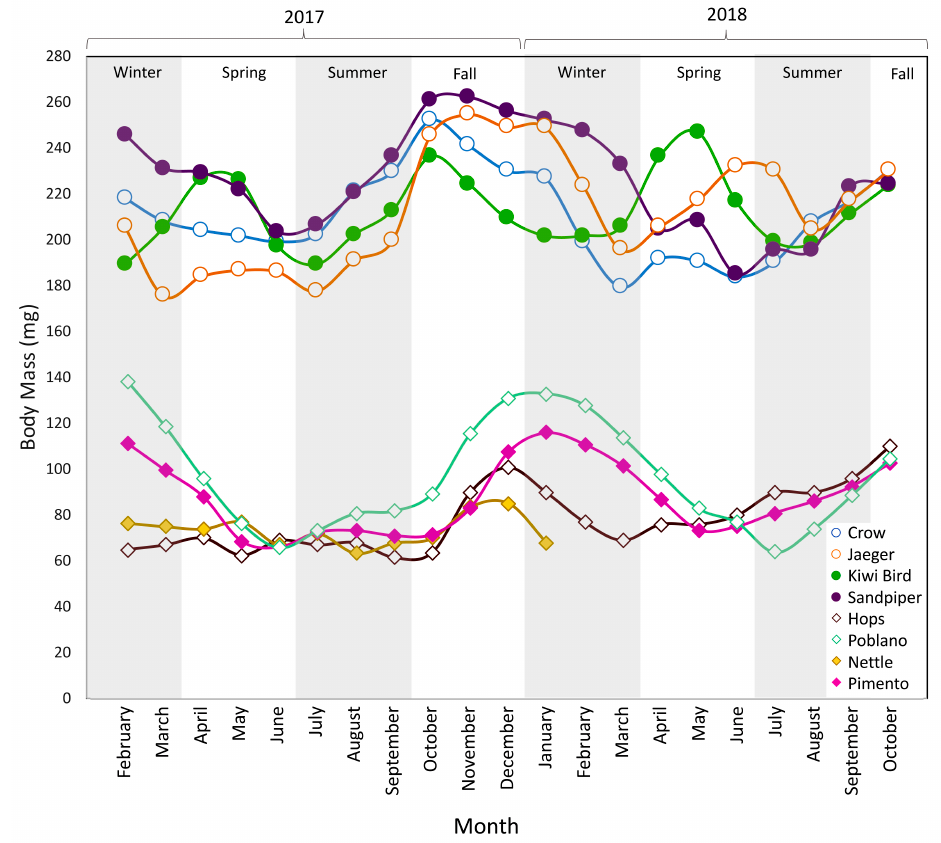
Figure 1. Monthly body mass measurements for each individual. Dwarf lemurs are circles and mouse lemurs are diamonds. Males are open symbols; females are filled. If more than one measurement was taken within the same month, the weights were